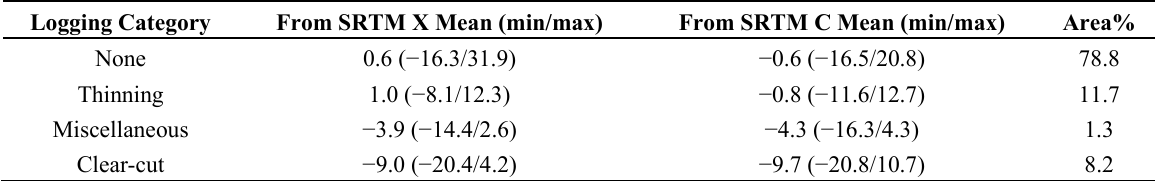
Table 4. Statistics for change in DSM distributed on logging categories ( N = 3,181 stands). Logging Category From SRTM X Mean (min/max) From SRTM C Mean (min/max) Area% None 0.6 ( − 16.3/31.9) 1.0 ( − 8.1/12.3) Miscellaneous − 3.9 ( −